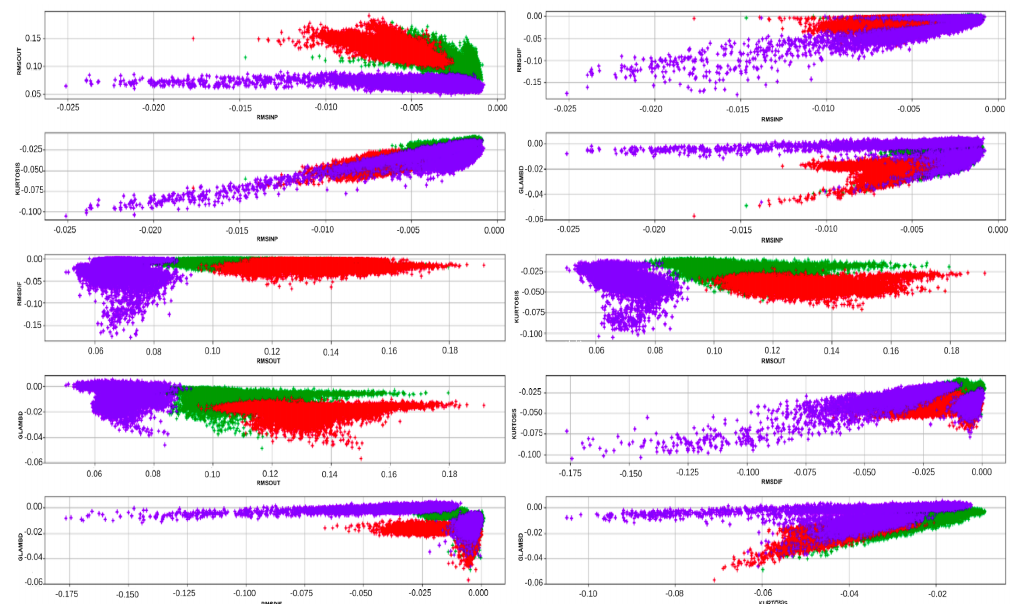
Figure 1. Scatter plot of five different correlation